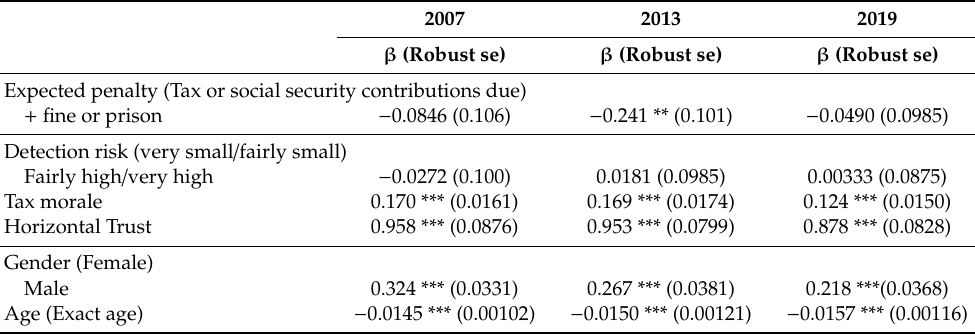
Table 3. Probit estimates of propensity to be tax non-compliant in